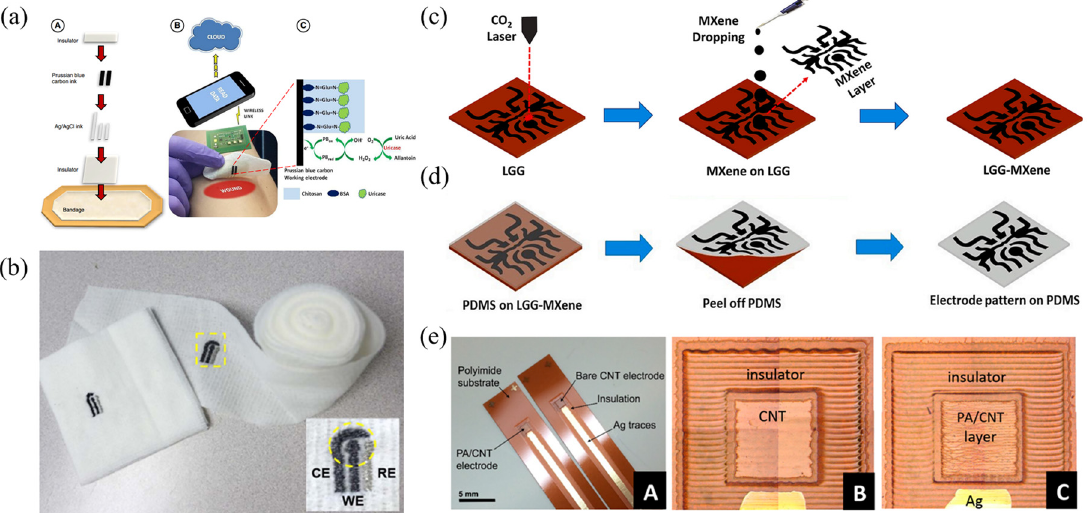
Figure 2. Wearable sensors for detecting uric acid levels in wounds. ( a ) Wearable sensor system based on UOx [62]. Copyright (2015) Elsevier. ( b ) Wearable uric acid detection sensor made by embroidery process on gauze [105]. Copyright (2017) Elsevier. ( c ) LGG-MXene electrode fabrication [106]. Copyright (2020) Elsevier. ( d ) Transferring the obtained LGG-MXene hybrid scaffold onto PDMS [106]. Copyright (2020) Elsevier. ( e ) Optical micrograph of two inkjet-printed electrodes on Kapton strips and laser scanning micrographs of the CNT and PA/CNT sensing areas [72]. Copyright (2019) American Chemical Society.